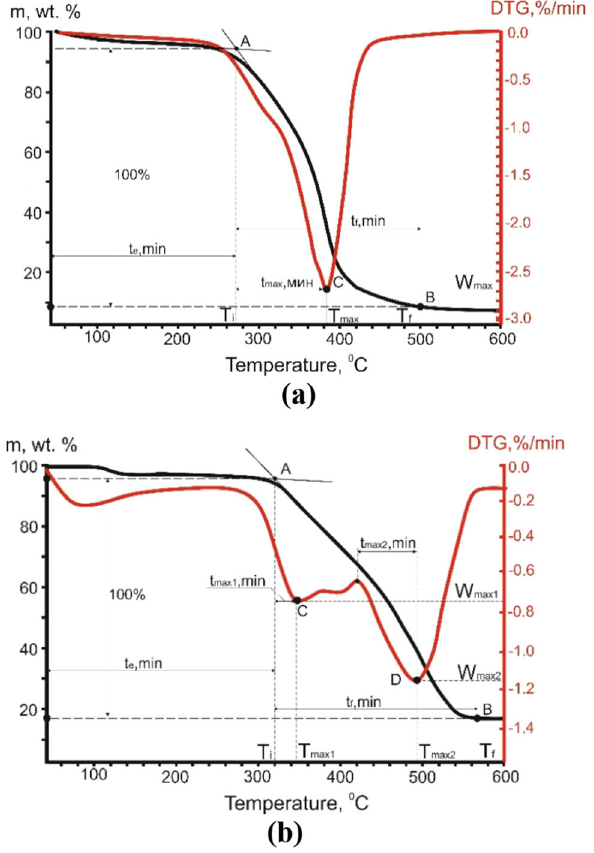
Fig. 1 The principle parameters for the oxidation of lignite a and bituminous coal b to be defined from TGA and DTG